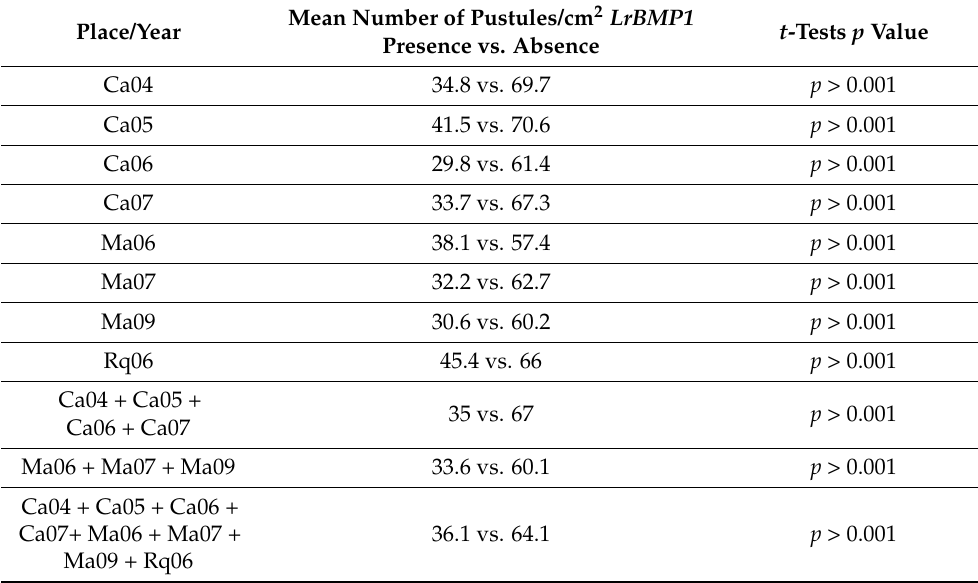
Table 4. Mean number of pustules per square centimeter in field trials of RILs with LrBMP1 presence vs. absence. Ca: Castelar, Ma: Maciel and Rq: